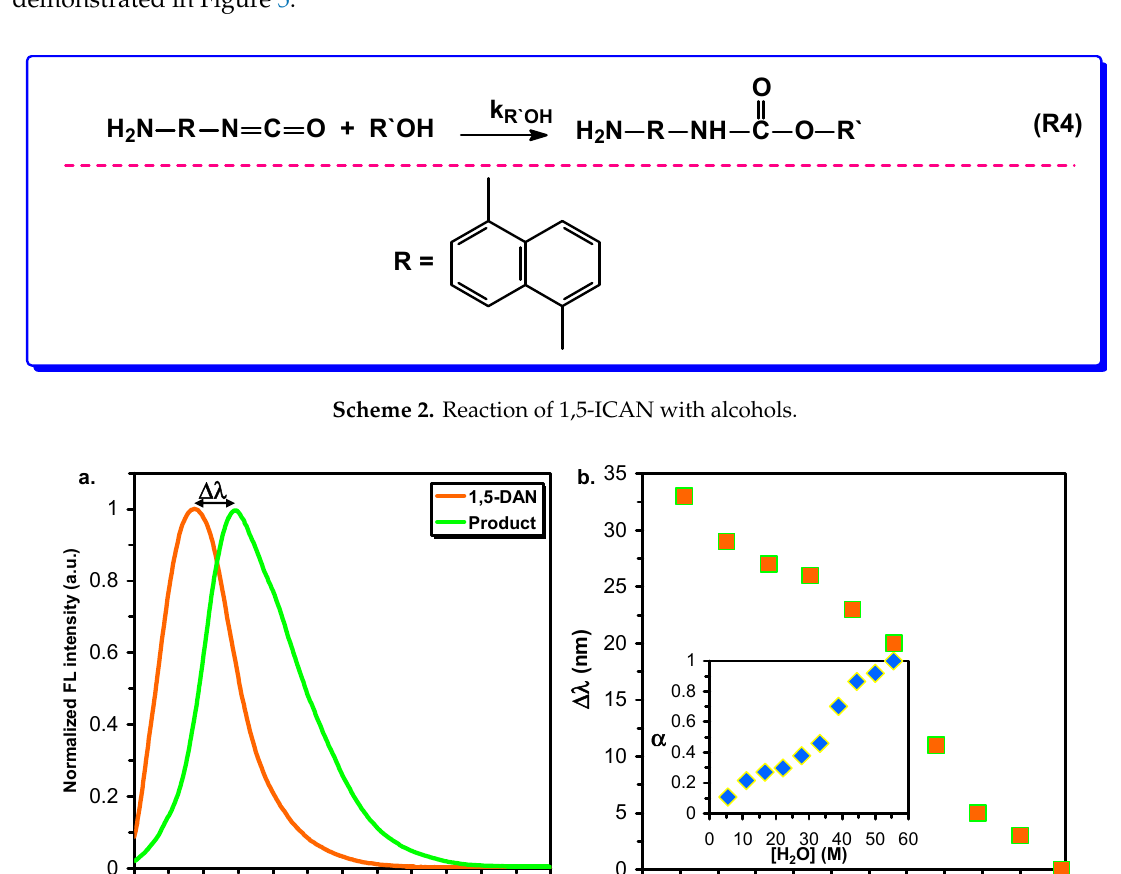
Figure 5. The normalized fluorescence (FL) spectra ( a ) and the difference ( Δλ )* in the emission maxima of 1,5-DAN and that of the product(s) formed in the reaction of 1,5-ICAN in the mixture of EtOH/water and HgCl 2 ( b ). The inset shows the variation of the α values with the water concentration in the water/EtOH mixture. Experimental conditions: [1,5-ICAN] = 2.5 × 10 − 6 mol/L, [HgCl 2 ] = 1.2 × 10 − 3 mol/L and T = 25 °C. * The Δλ values indicated were obtained using the same solvent composition .